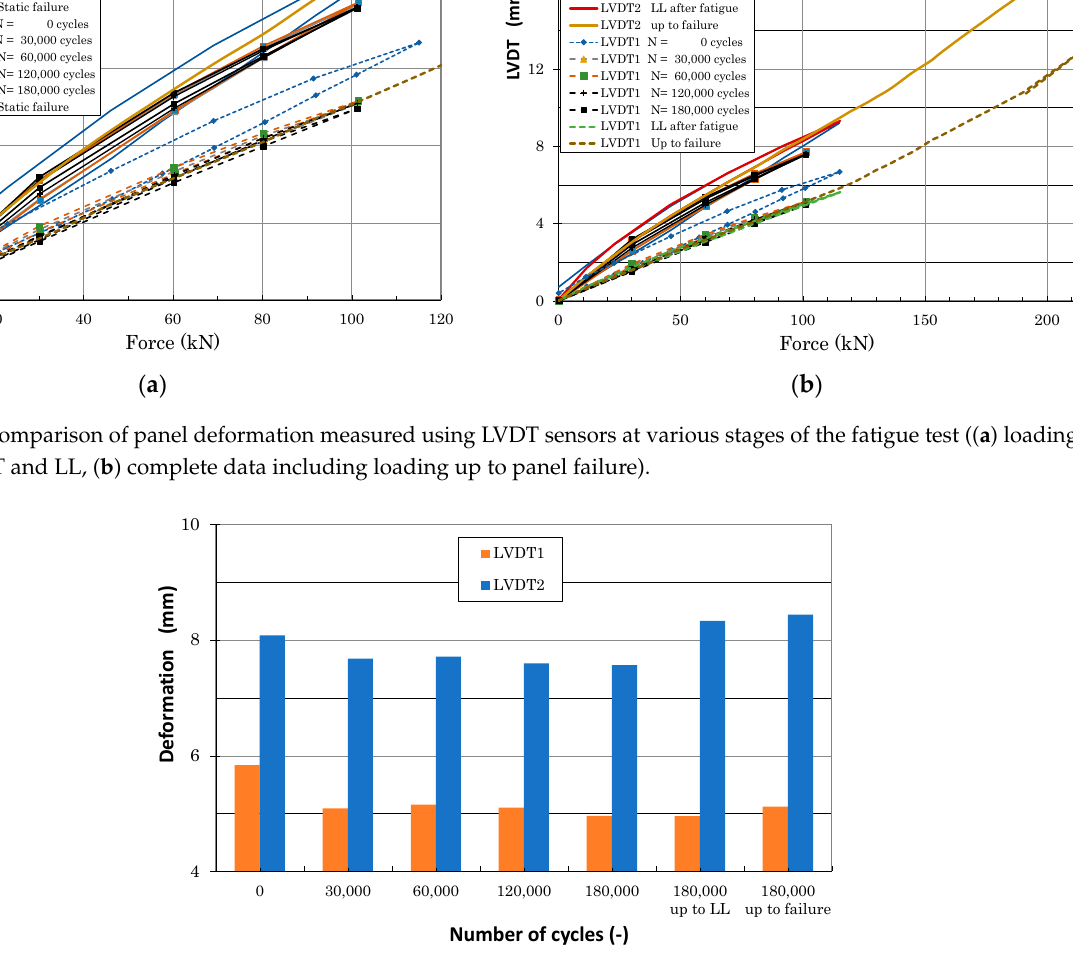
Figure 19. Comparison of panel displacement measured at DPFAT load in various stages of the testing campaign.